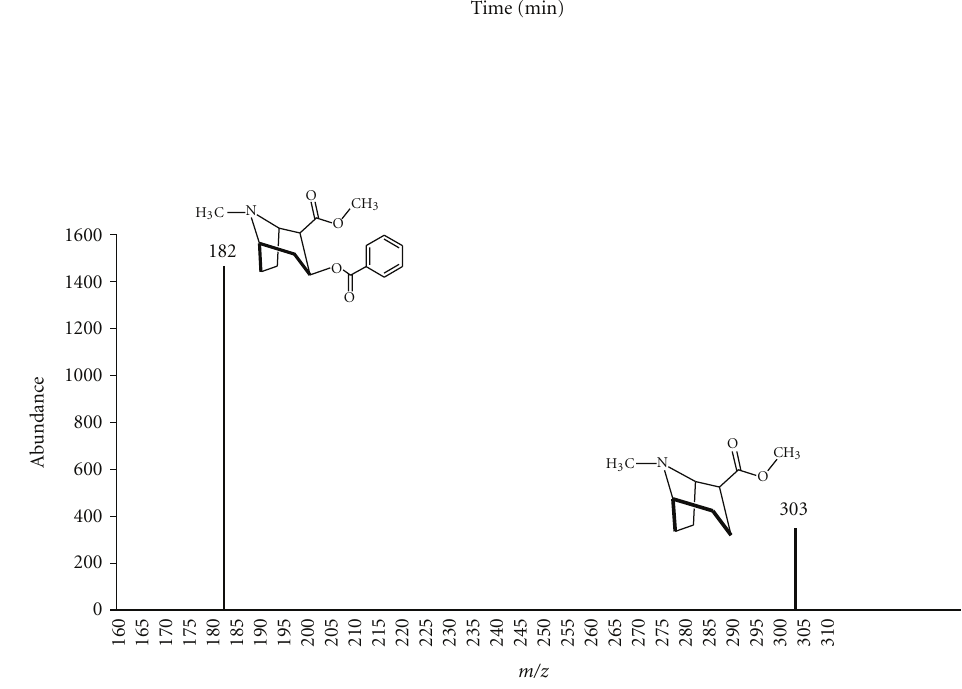
Figure 2: GC-MS chromatogram and fragmentation pathway of cocaine.